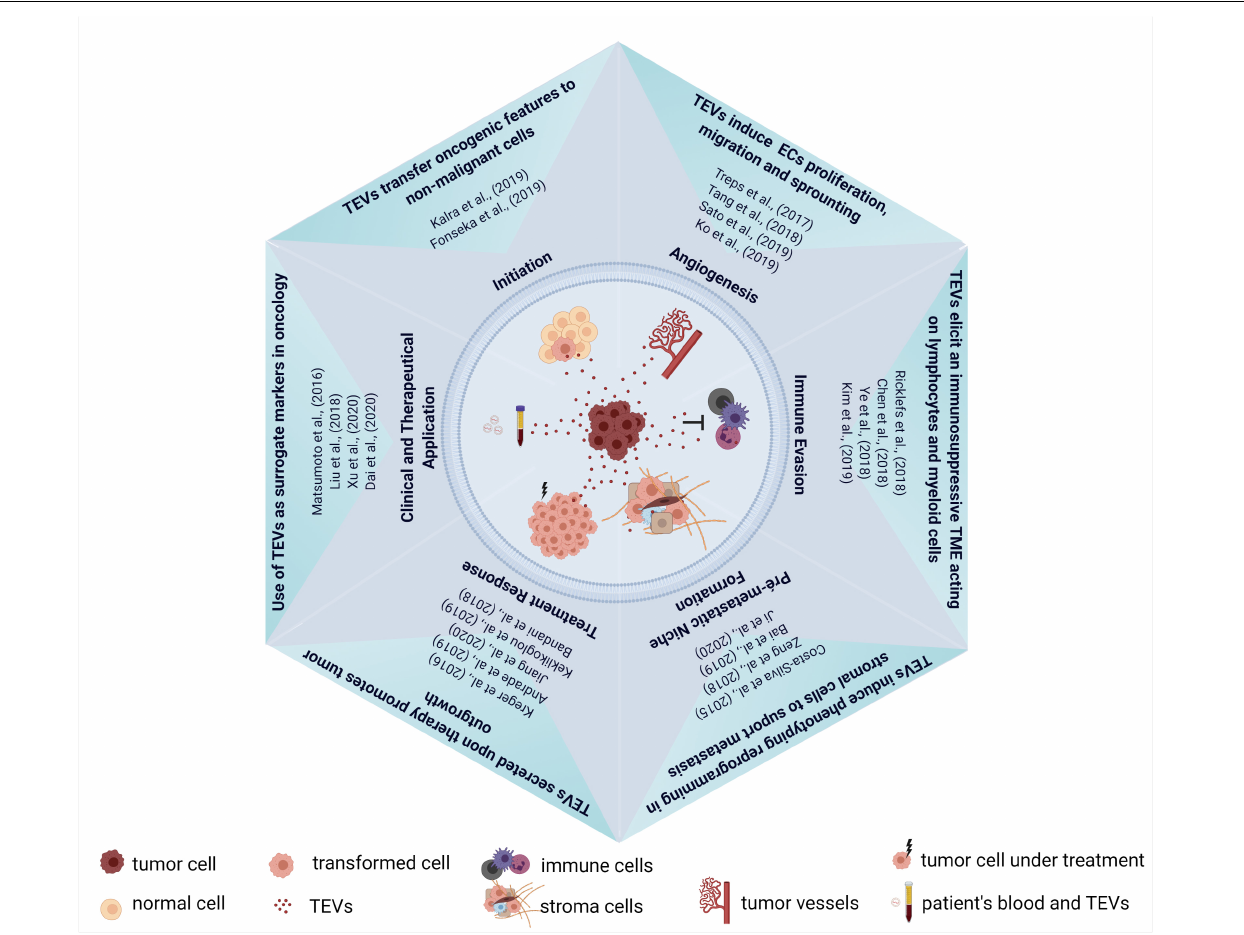
FIGURE 2 | Schematic representation of TEVs in cancer biology. Upper corner: pro-tumorigenic effect of TEVs in tumor initiation and progression. Right corner: establishment of an immunosuppressive environment by TEVs. Lower corner: effect of TEVs in pre-metastatic niche formation and in tumor repopulation after therapy. Left corner: the use of TEVs as theranostic biomarkers in oncology. Some of the published articles illustrating these mains findings of TEVs were cited in the figure. Figure created using Biorender.